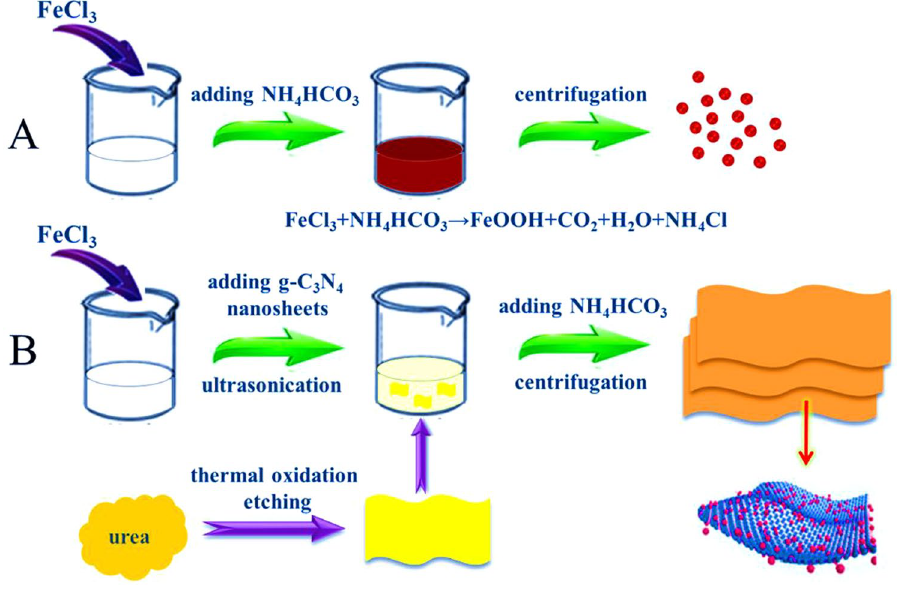
Figure 1. Schematic illustration of the synthesis of ( A ) a-FeOOH and ( B ) a-FeOOH/CNNS composites.